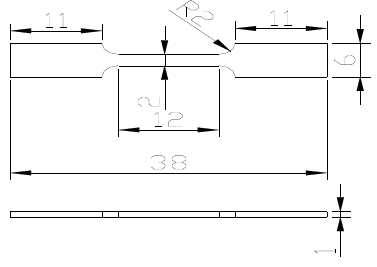
Figure 1. Geometry and size of tensile specimen (unit: mm).